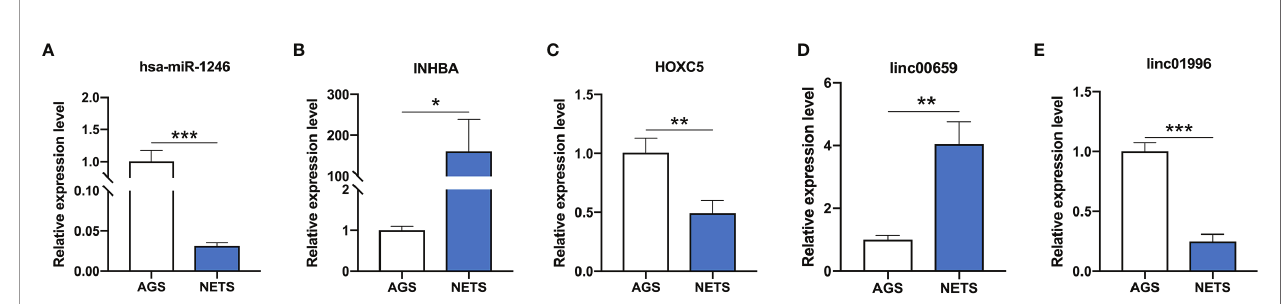
FIGURE 3 | The expression of genes validated by real-time PCR. (A) The expression of hsa-miR-1246 in NET-treated GC cells. (B) The expression of INHBA in NET-treated GC cells. (C) The expression of HOXC5 in NET-treated GC cells. (D) The expression of linc00659 in NET-treated GC cells. (E) The expression of linc01996 in NET-treated GC cells. n = 3, * p < 0.05, ** p < 0.01, *** p